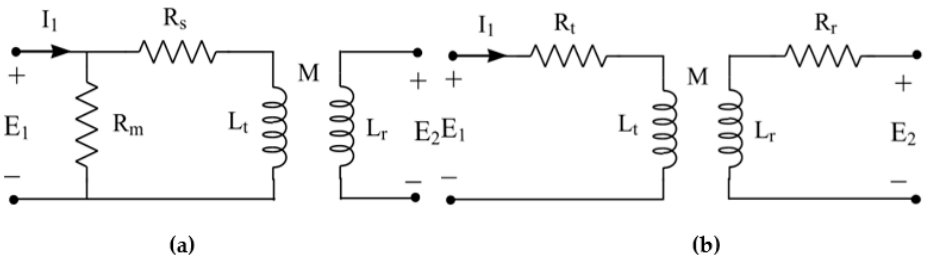
Figure 8. Equivalent circuits of the coupled pads. ( a ) transformer-like “classical“ equivalent circuit; ( b ) specific equivalent circuit.